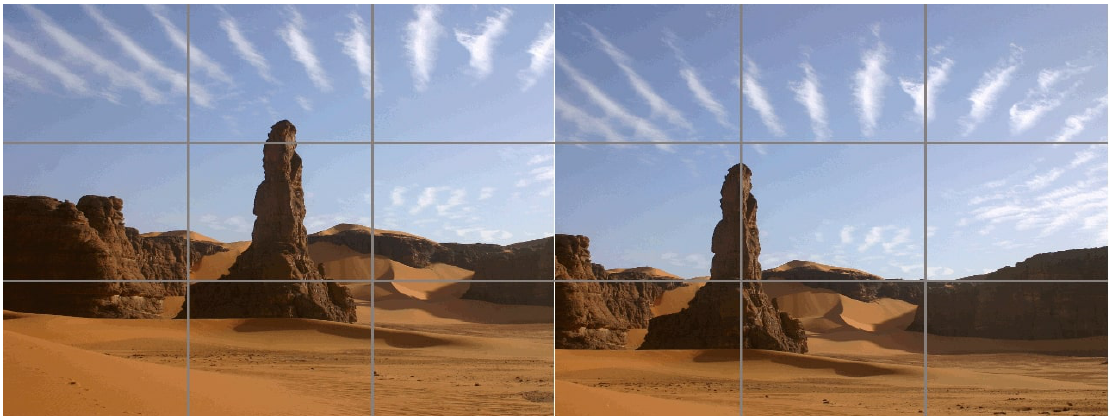
Figure 3. Two pictures of the Moul n’ga Cirque in the Tadrart region, Southeast Algeria, with wavy clouds above. The picture on the right is cropped with the rule of thirds; the one on the left is